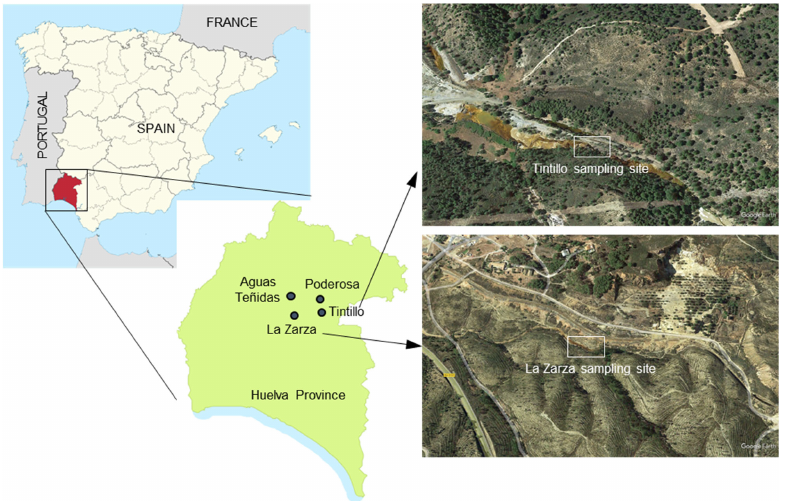
Figure 1. Location of sampling points for this study and satellite (Google Earth) images of Tintillo and La Zarza sampling sites.